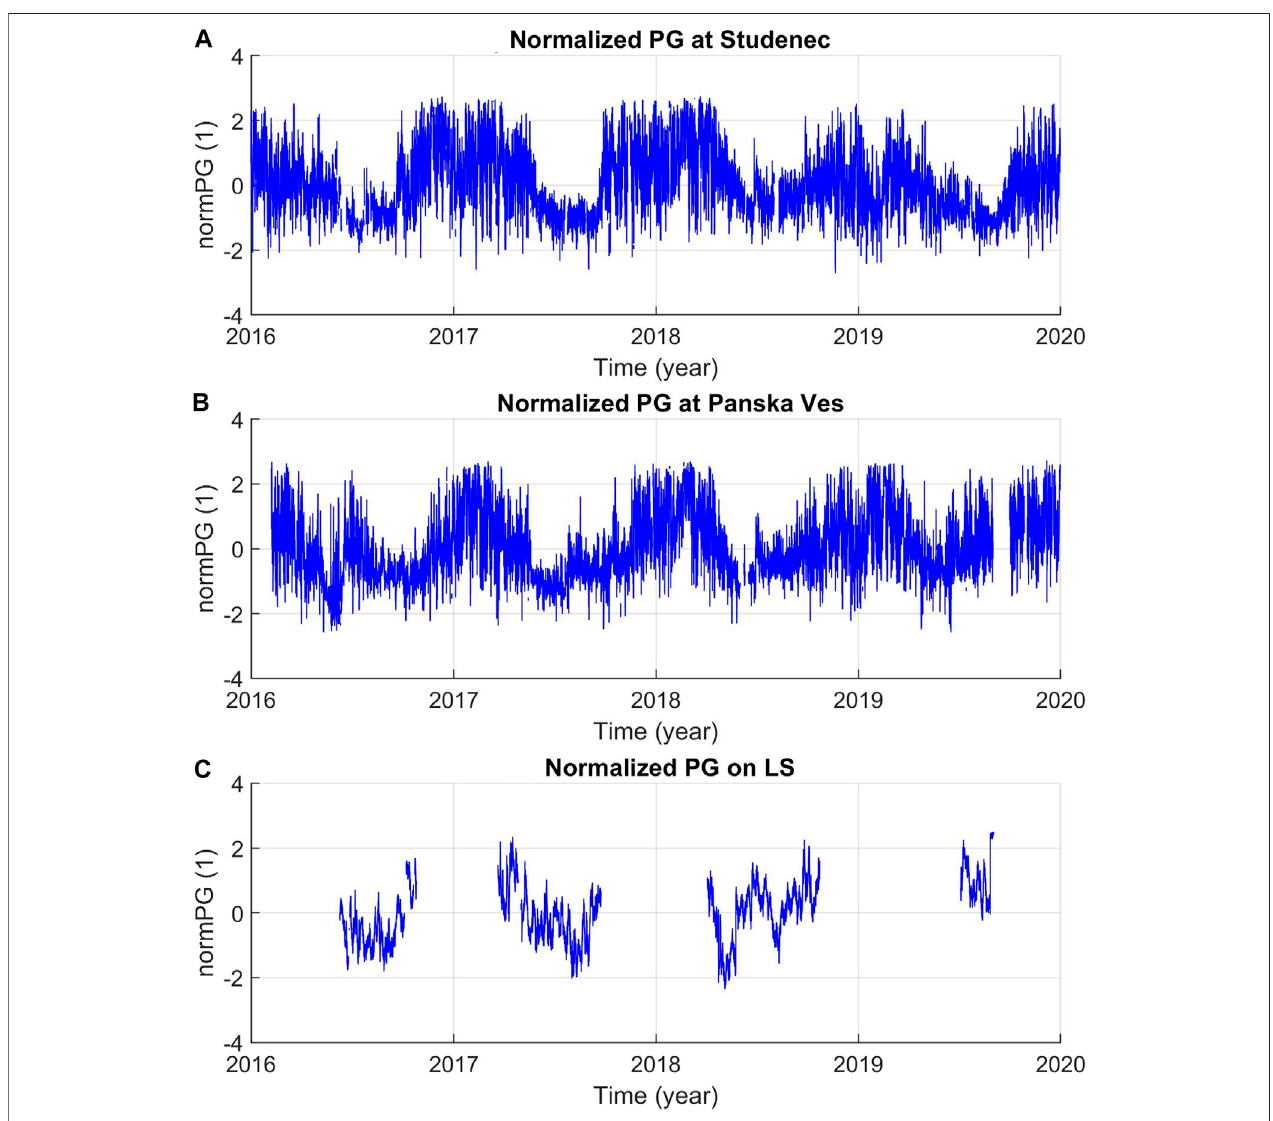
FIGURE 7 | Normalized PG (proxy for fair weather) at Studenec (A) , Panska Ves (B) , and LS (C) .